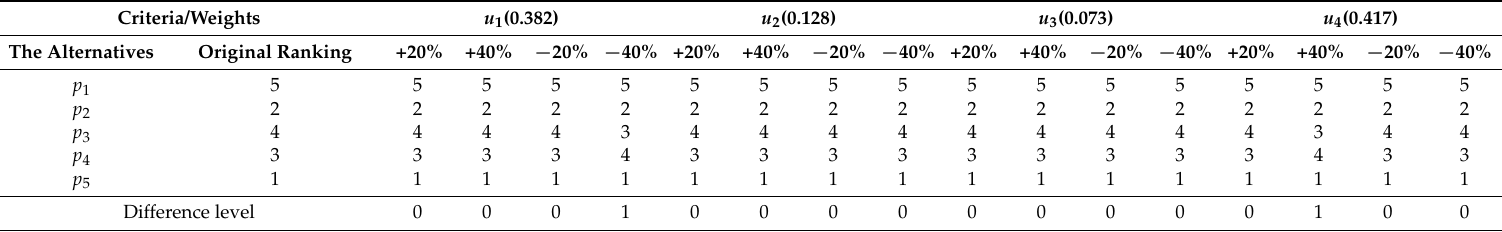
Table 8. Difference level between the original ranking and each adjusted ranking obtained based on the changing criteria